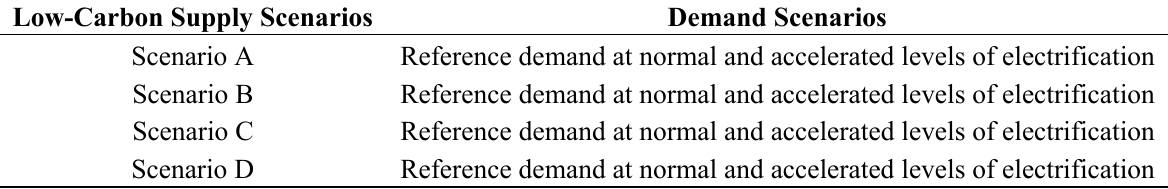
Table 14. Scenarios used for analyzing contributions of electrification to carbon dioxide mitigation in different low-carbon supply scenarios.